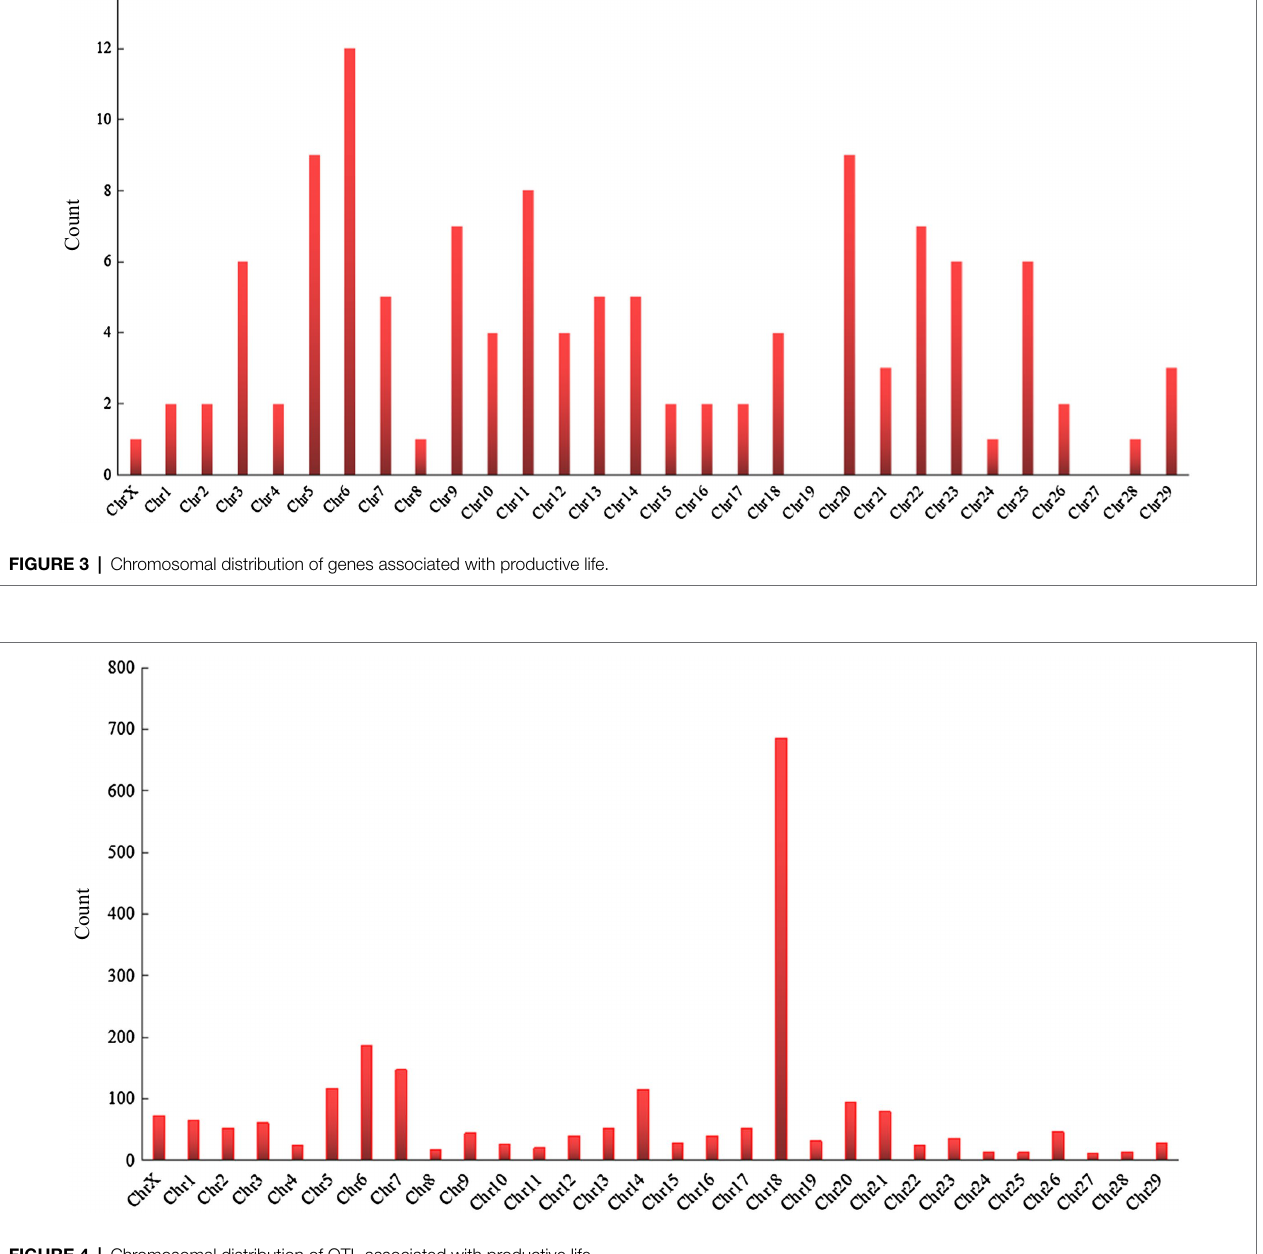
FIGURE 4 | Chromosomal distribution of QTL associated with productive